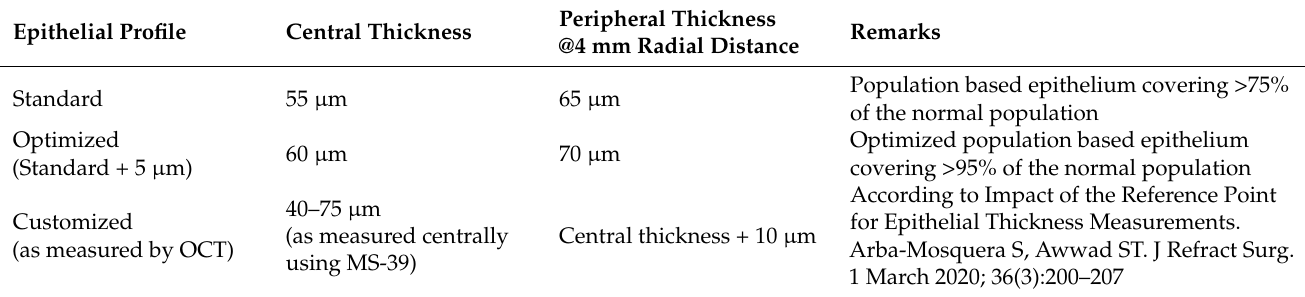
Table 1. Summarizes the different ablation profiles of the epithelium for